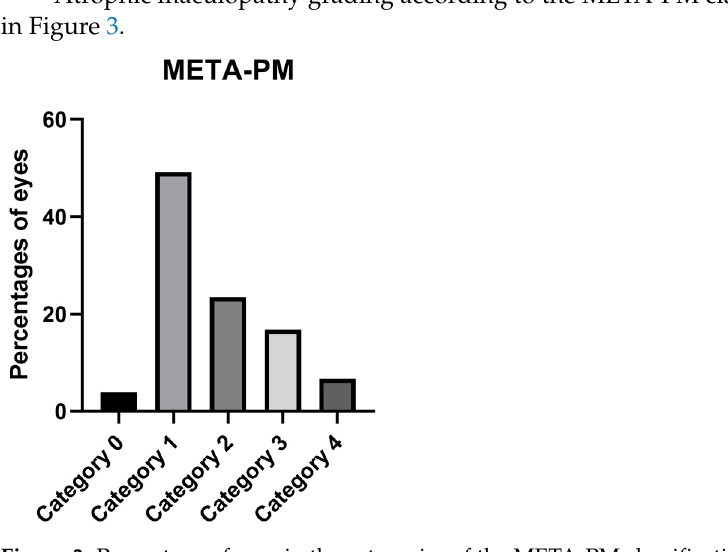
Figure 2. Types of staphylomas: ( A ) wide macular; ( B ) narrow macular; ( C ) nasal; ( D ) inferior; ( E ) peripapillary, and ( F ) other types. All images are horizontal in orientation except D. Atrophic maculopathy grading according to the META-PM classification is pre- sented in Figure 3.